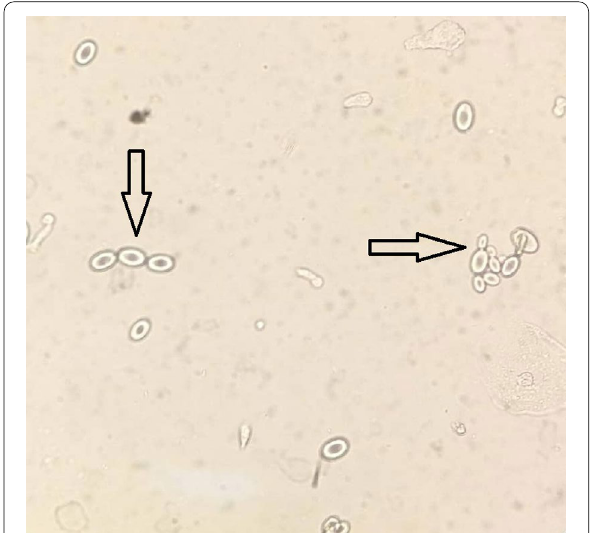
Fig. 1 Epithelial and budding yeast cells in urine of a bitch under microscope (magnification 40